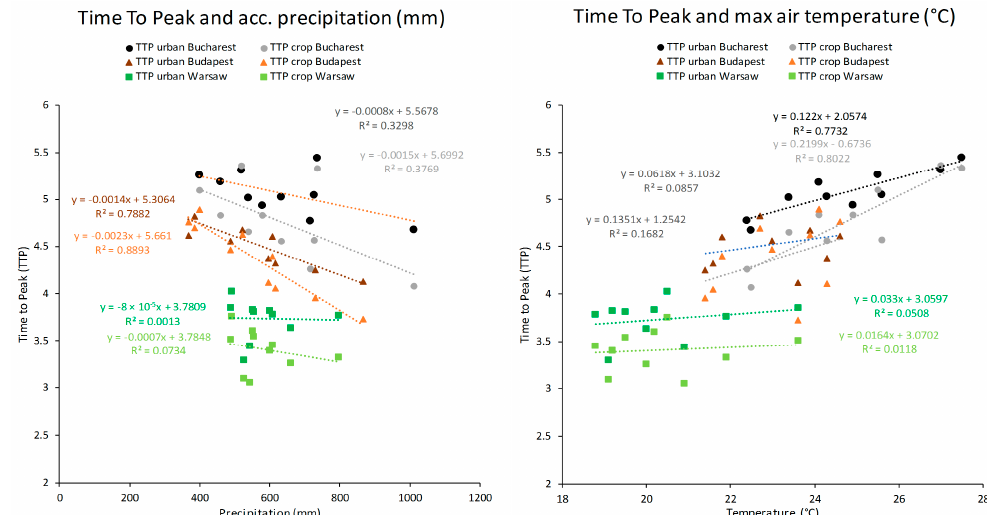
Figure 12. Relationships between time to peak and accumulated precipitation ( left ) and maximum air temperature ( right ).